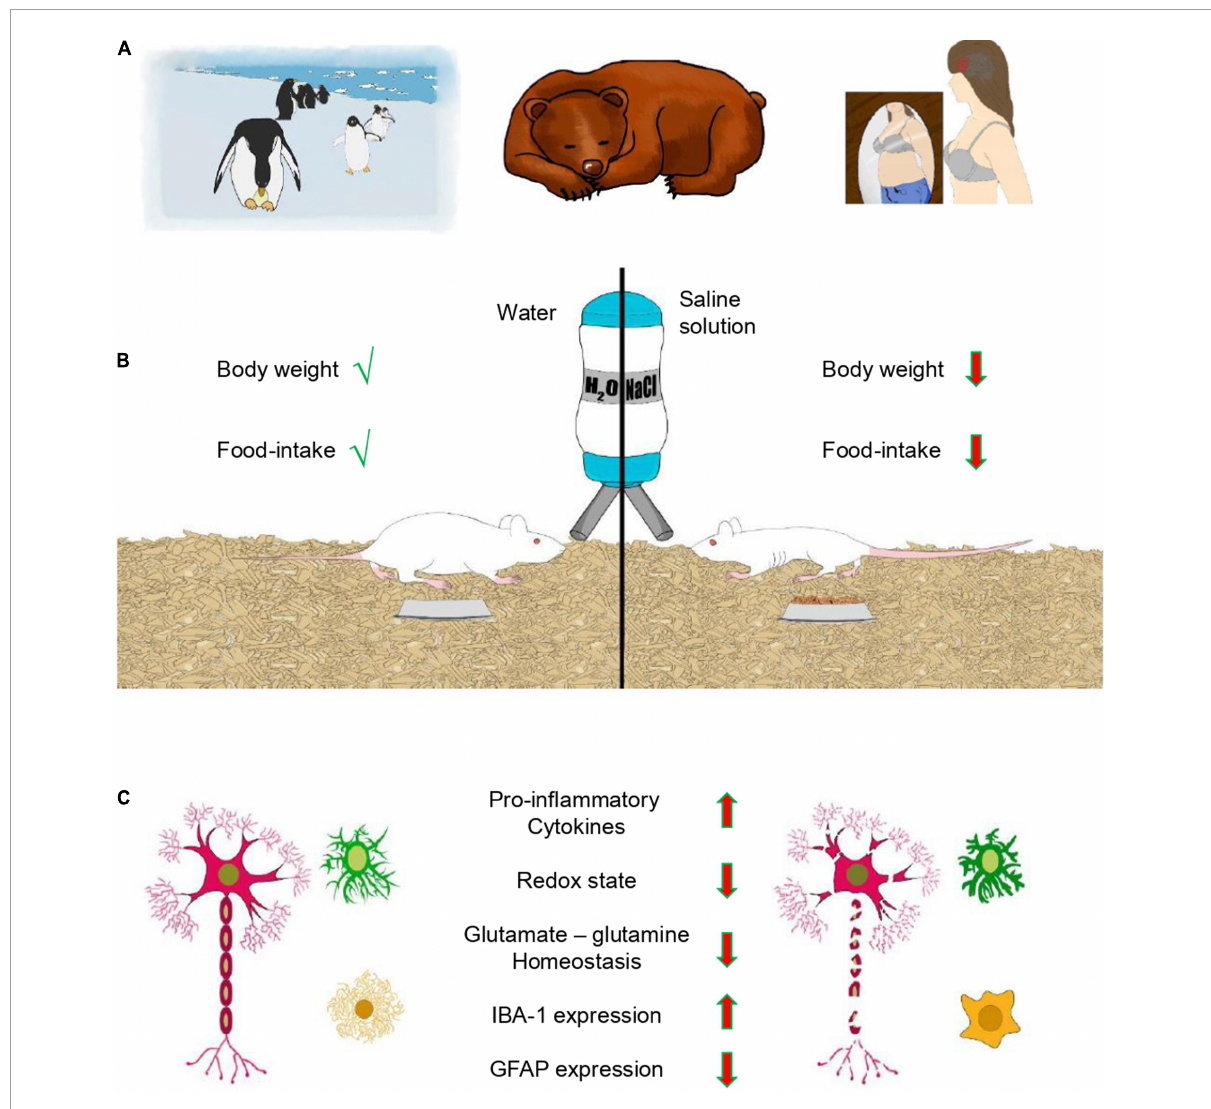
FIGURE1 Anorexia and glial cells. (A) Examples of different types of anorexia. Male penguins during incubation and bears in hibernation experience adaptive anorexia (animal anorexia), which is physiologically regulated and part of the life cycle. In contrast, anorexia nervosa (AN) is pathological. (B) Dehydration-induced anorexia (DIA) is another example of adaptive anorexia, where animals reduce food intake in response to dehydration resulting in loss of body weight. (C) DIA and glial cells. Feeding provides nutrients and glial cells maintain the homeostasis of the brain. DIA induces a pro-inflammatory phenotype of glial cells with a de-ramified morphology, resulting in augmented expression of pro-inflammatory cytokines (TNF α , IL-1 β , and IL-6) and the microglial marker IBA-1. These changes correlate with a decreased redox state, disrupted glutamate-glutamine homeostasis and diminished expression of the astroglial marker GFAP in the prefrontal cortex of young female